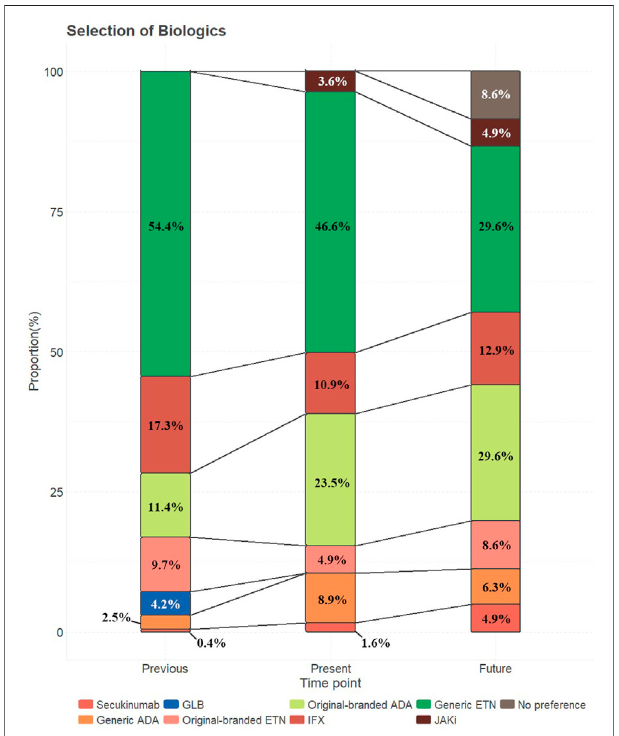
FIGURE 2 | Proportion of reasons for withdrawal/change of or preference for